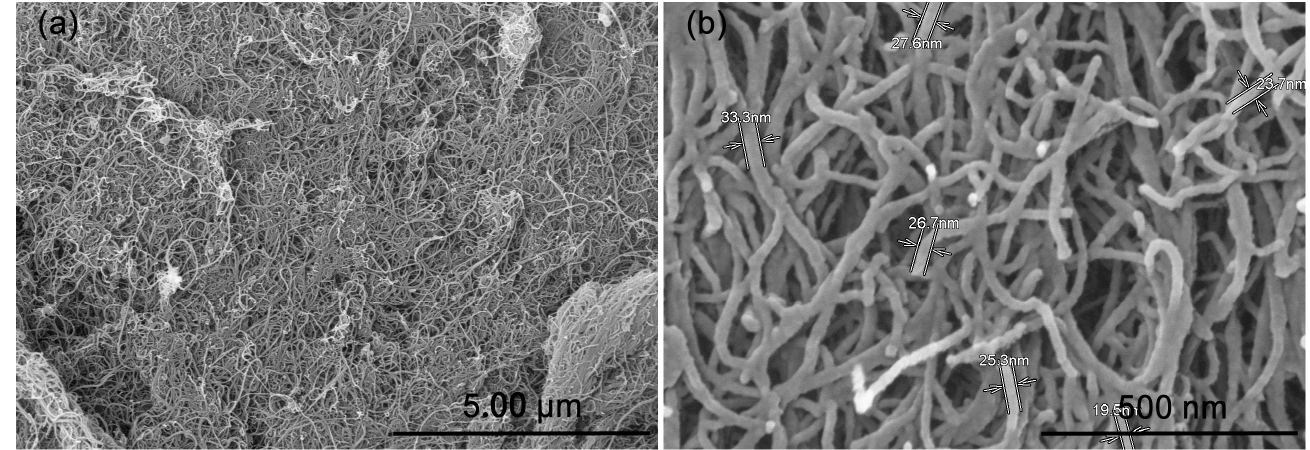
Figure 1. SEM images of CNTs powder: ( a ) low magnification; ( b ) high magnification.